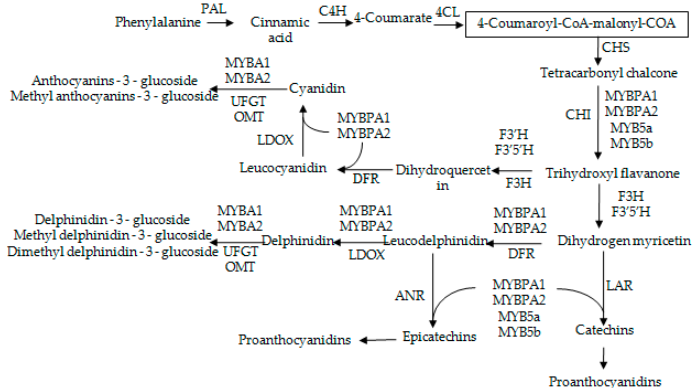
Figure 1. Biosynthetic pathway of anthocyanins and proanthocyanins in grape. Notes: Transcription regulators: VvMYBPA1, VvMYBPA2, VvMYBA1, VvMYBA2, VvMYB5a, VvMYB5b. PAL: